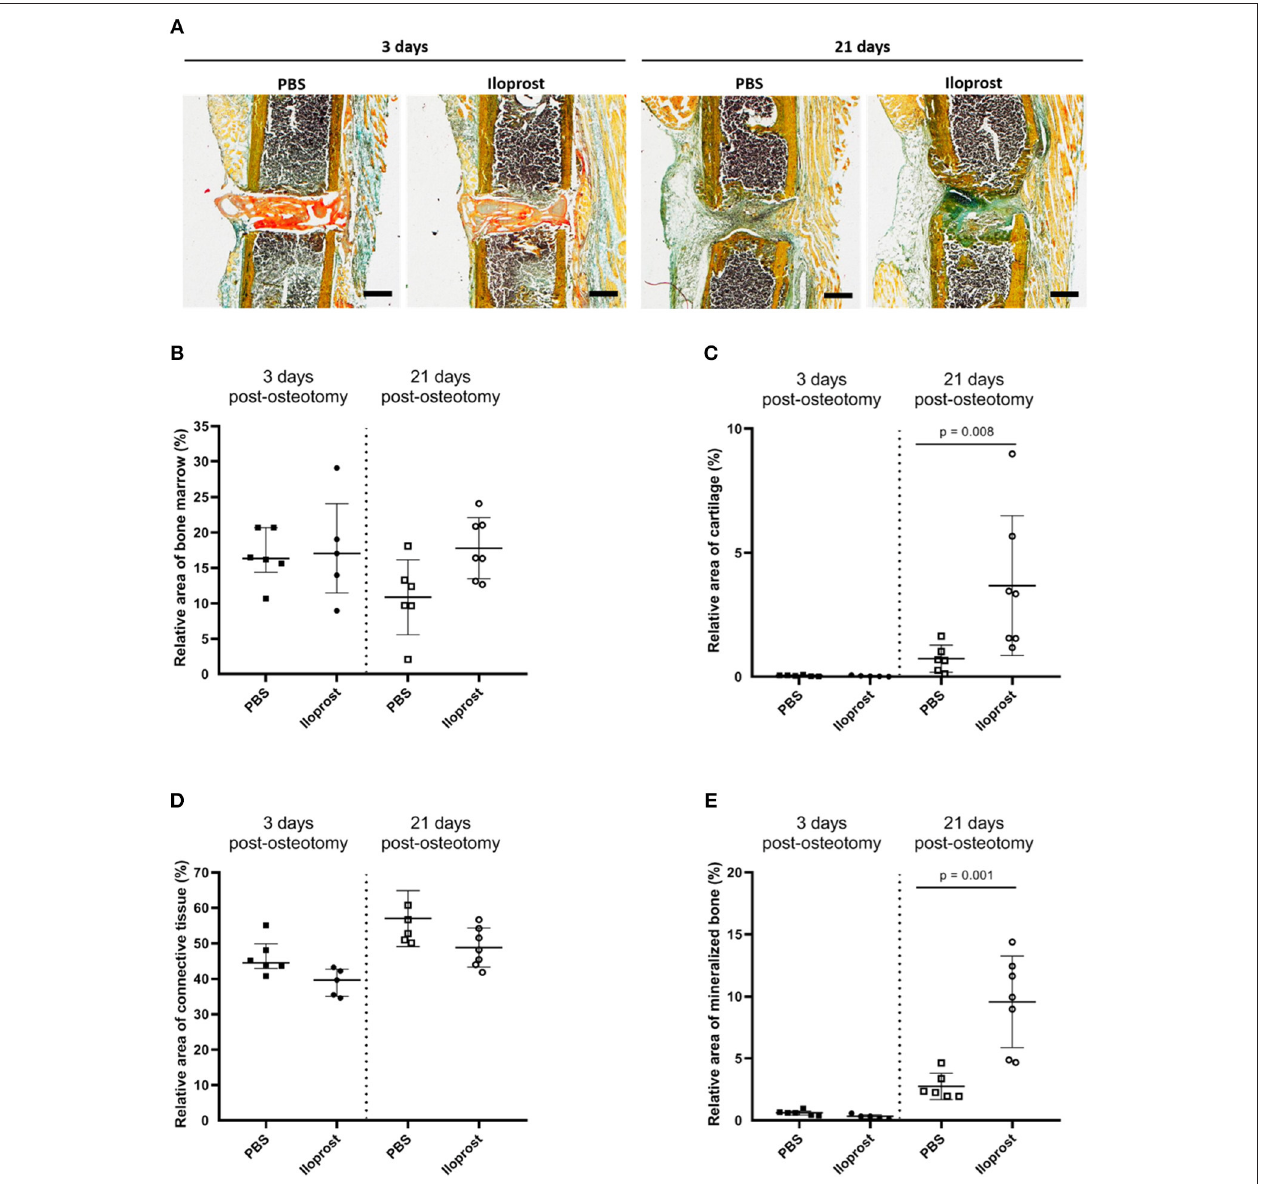
FIGURE 10 | Histological analysis of in vivo experiments in mouse osteotomies at days 3 and 21 post-osteotomy. (A) Representative Movat’s pentachrome pictures are displayed for the respective time point and group. (B–E) Histomorphometrical analysis of the Movat Pentachrome stainings: (B) bone marrow, (C) cartilage tissue, (D) connective tissue, and (E) mineralized bone tissue. Color coding of the Movat Pentachrome staining: mineralized bone = yellow, cartilage = dark blue-green, connective tissue = light blue-green, muscle fibers = light orange, cell nuclei = purple, fibrin clot = red/orange. Scale bars equal 500 µ m, n =